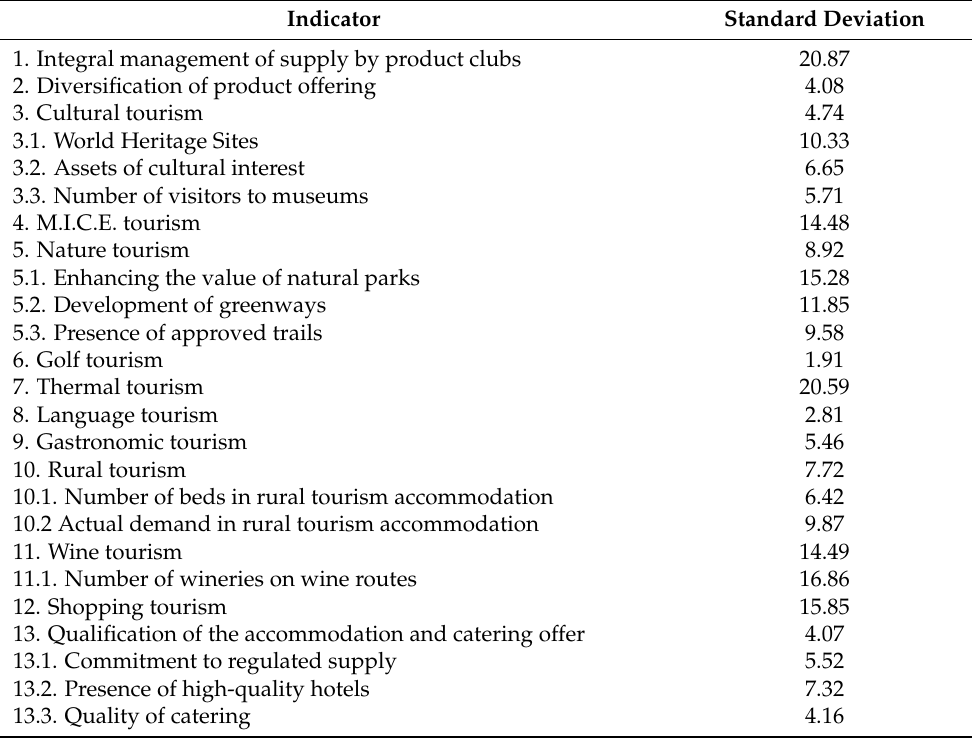
Table 1. Standard deviation of differences in indicator values between 2010 and